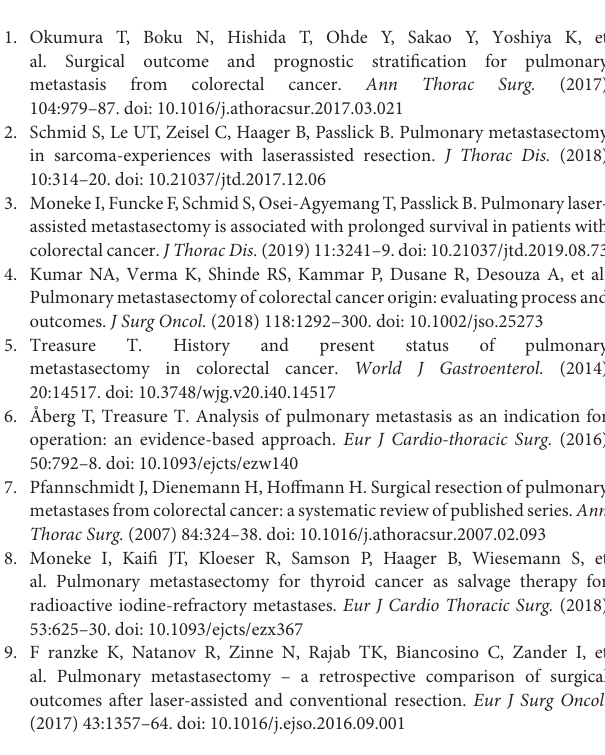
Supplementary Figure 1 | Standardized measurement of the pulmonary metastases was performed by a board certified radiologist (ID). The size of the metastases was determined by multiplication of the long and short axis in millimeter, which were measured perpendicularly in the axial scans. The depth of the metastases was defined as the shortest distance from the pleural space to the surface of the